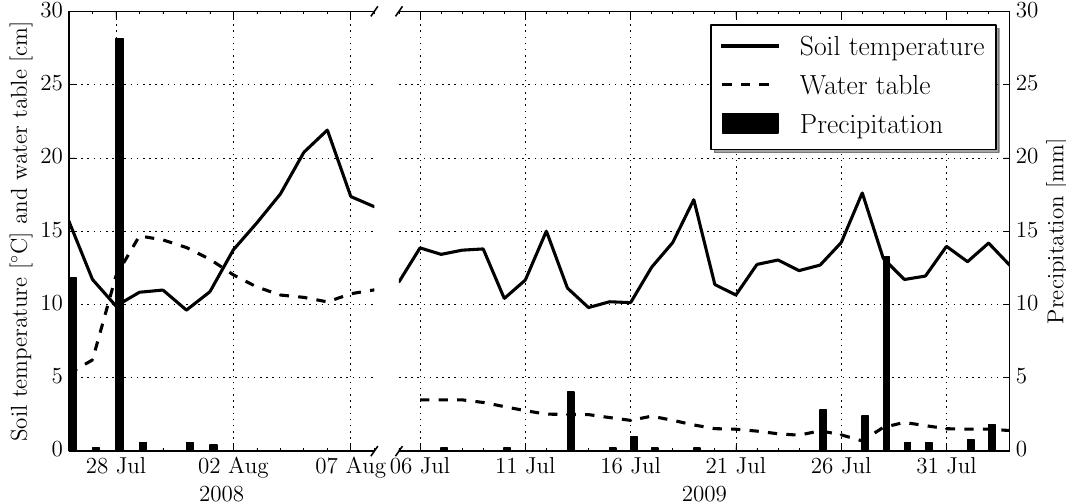
Figure 2. Temporal dynamics of daily soil temperature at 4cm depth (solid line), water table position (dashed line) and daily precipitation (bars) for the EC measurement periods in 2008 and